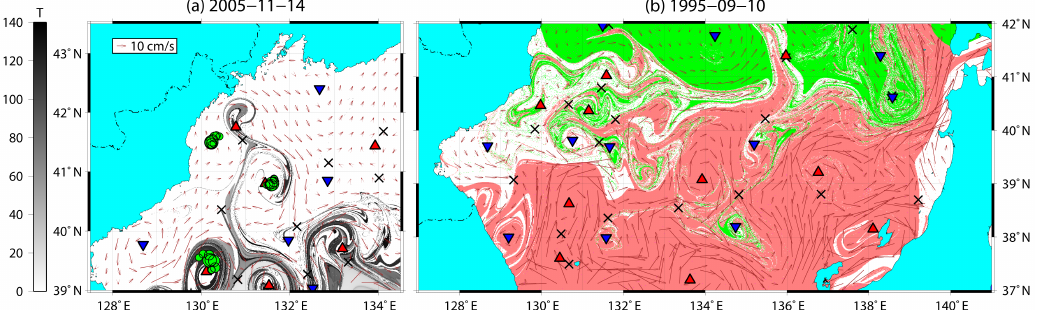
Figure 6. (a) The Lagrangian map documents intrusions of subtropical water to the southern coast of Russia through the western gate. Greyscale shows travelling time T in days that it took for subtropical tracers to reach their locations on the map from latitude 37 ◦ N to the dates shown. “White” tracers are those which did not come from latitude 37 ◦ N for the integration period, 140 days. Locations of available drifters are shown by full circles for 1 day before and after the dates indicated. (b) The drift map documents a streamer-like northward transport of subtropical water across the front through a central gate with the help of the cyclone with the centre at 41.5 ◦ N, 134.4 ◦ E. Red and green code the waters that entered the studied area for 2 years through its southern and northern boundaries, respectively. White indicates the tracers arriving at the